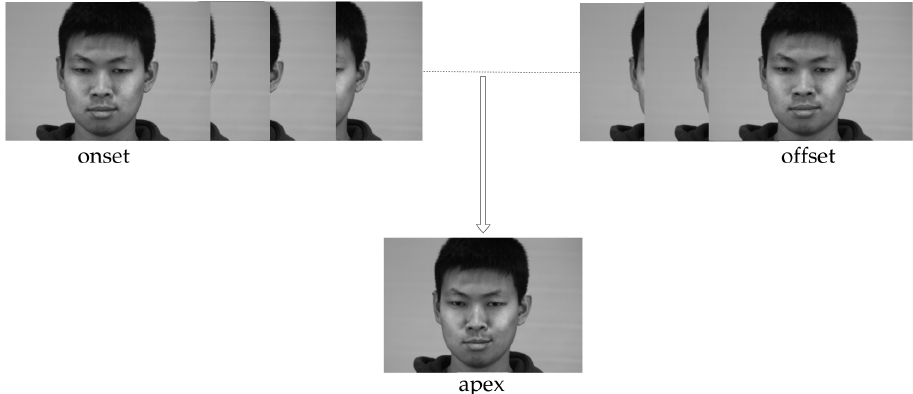
Figure 1. Example of a Micro-Expression (ME): the maximum movement intensity occurs at the apex